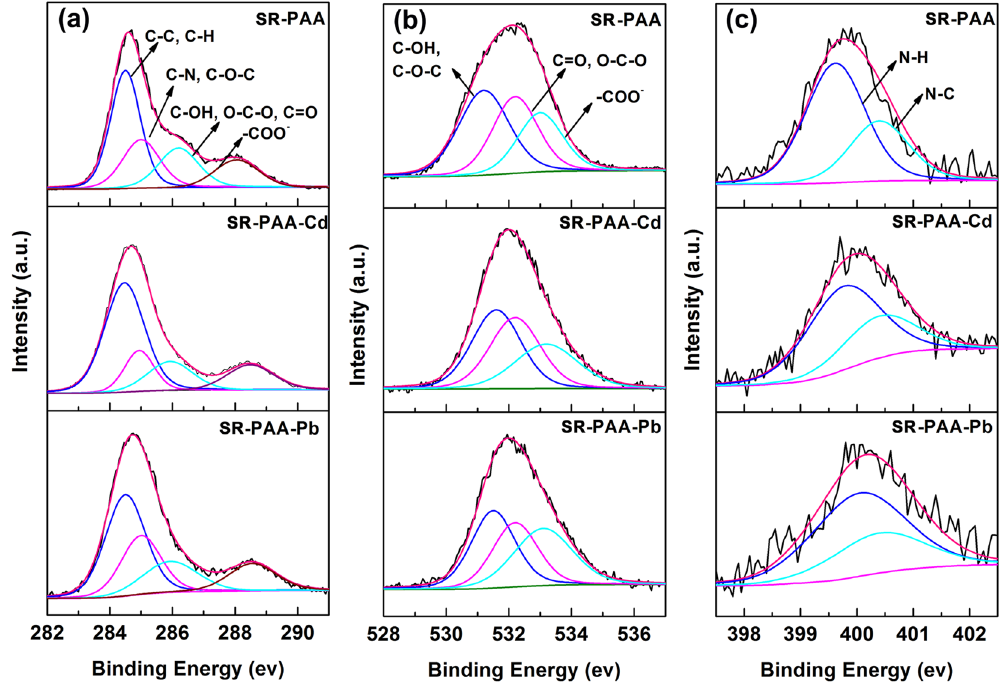
Figure 4. XPS spectra of ( a ) C 1s, ( b ) O 1s and ( c ) N 1s peaks for SR–PAA, SR–PAA–Cd and SR–PAA–Pb